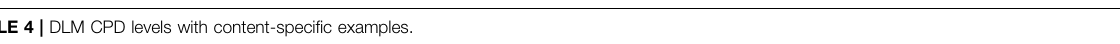
TABLE 4 | DLM CPD levels with content-speci fi c